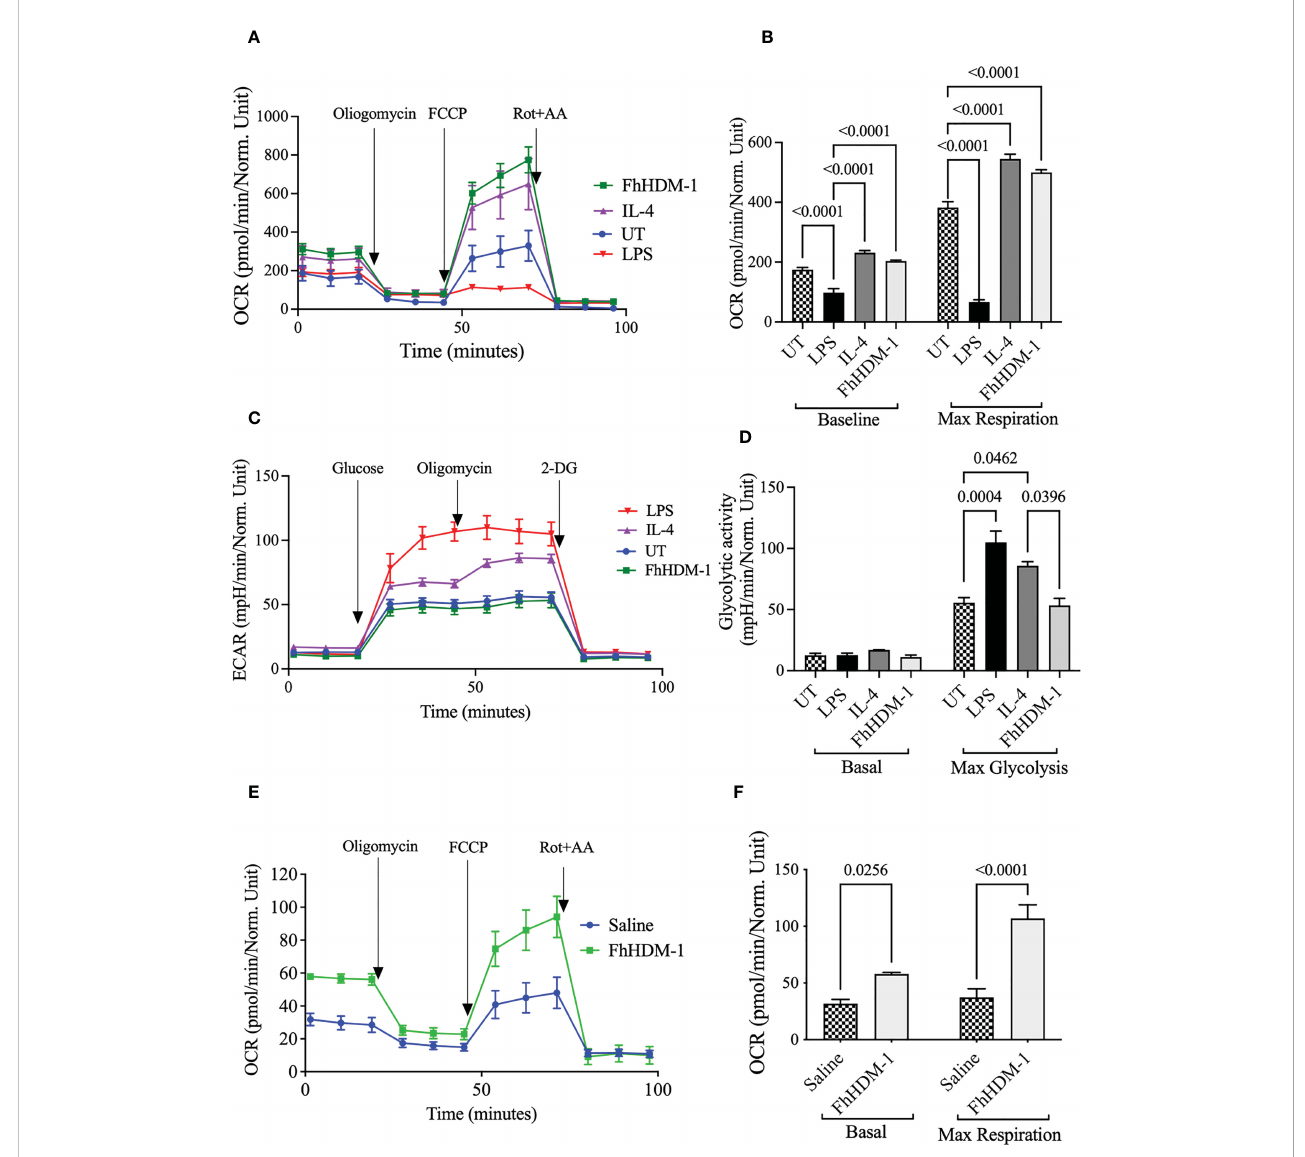
FIGURE 1 Unlike IL-4, treatment of macrophages with FhHDM-1 enhances oxidative phosphorylation without modulating glycolytic activity. (A) BMDMs were either untreated (UT) or treated with LPS (20ng/ml), IL-4 (20ng/ml), or FhHDM-1 (2.5µM) for 24h (n=5). The oxygen consumption rate (OCR) was measured at basal levels and following sequential treatments with oligomycin, FCCP, and rotenone/antimycin A (Rot+AA) to determine (B) the maximum respiratory capacity of cells. (C, D) BMDMs were cultured with media (UT), FhHDM-1 (2.5µM), LPS (20ng/mL) or IL-4 (20ng/mL) for 24h (n=5). Then glycolytic activity was determined by measuring (C) the extracellular acidi fi cation rate (ECAR) and (D) maximum glycolytic activity as cells were treated with glucose, oligomycin and 2-DG (2-deoxy-glucose). Statistical signi fi cance was determined by a one-way ANOVA with Tukey ’ s multiple comparison test. Data is representative of fi ve independent experiments and is presented as means ± SEMs. (E) OCR was measured at basal levels and following sequential treatments with oligomycin, FCCP, and rotenone/antimycin A (Rot+AA) in peritoneal macrophages harvested from mice (n=10) that had received a single i.p. injection of either FhHDM-1 or saline. This data was used to (F) determine the maximum respiratory capacity of cells. Data is presented as means ± SEMs. Statistical signi fi cance was determined by an unpaired, two tailed Welch ’ s